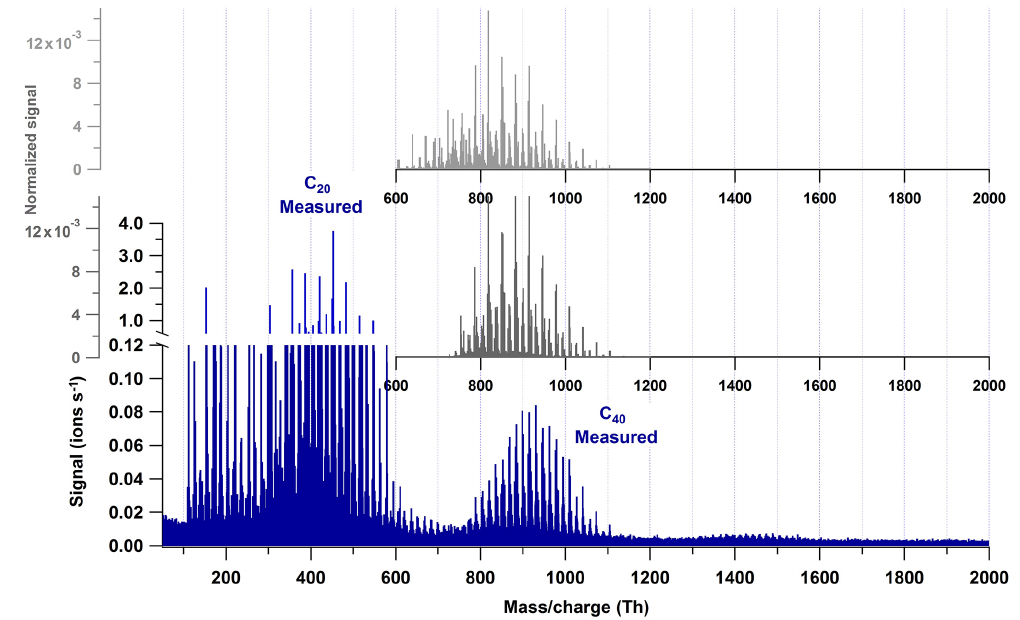
Figure 5. Comparison of the positive ion mode spectrum measured (blue), the C 40 band obtained by the combination of all C 20 molecules (light gray), and the C 40 band obtained by combination of only the C 20 molecules with O / C ≥ 0.4 (dark gray). The low or absent signals at the lower masses obtained by permutation suggest that only the highly oxygenated dimers are able to cluster and form C 40